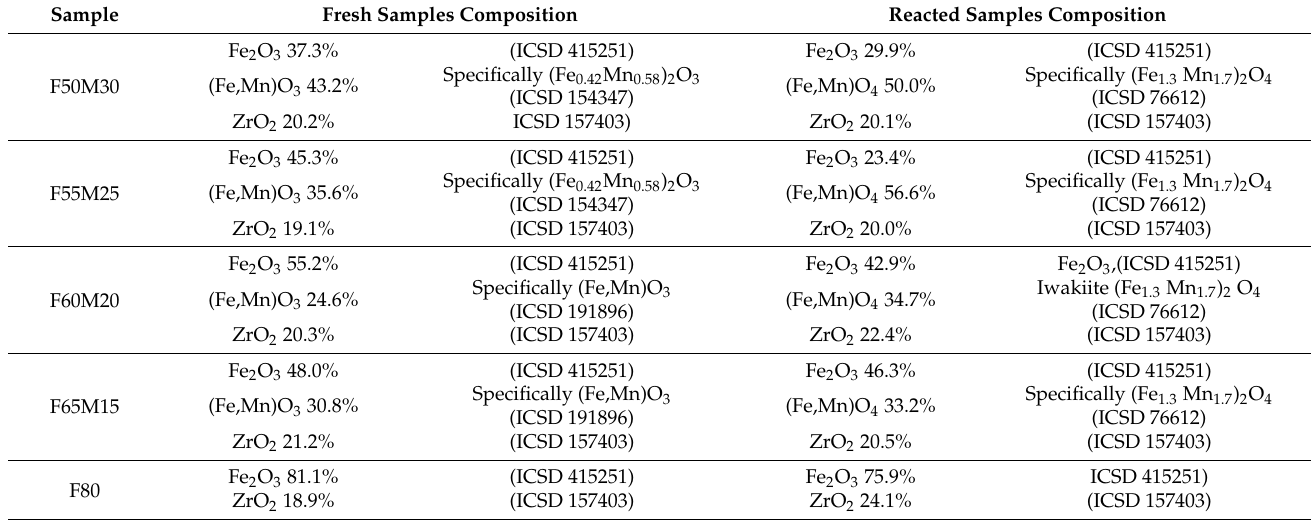
Table 1. Phase composition data for fresh and reacted